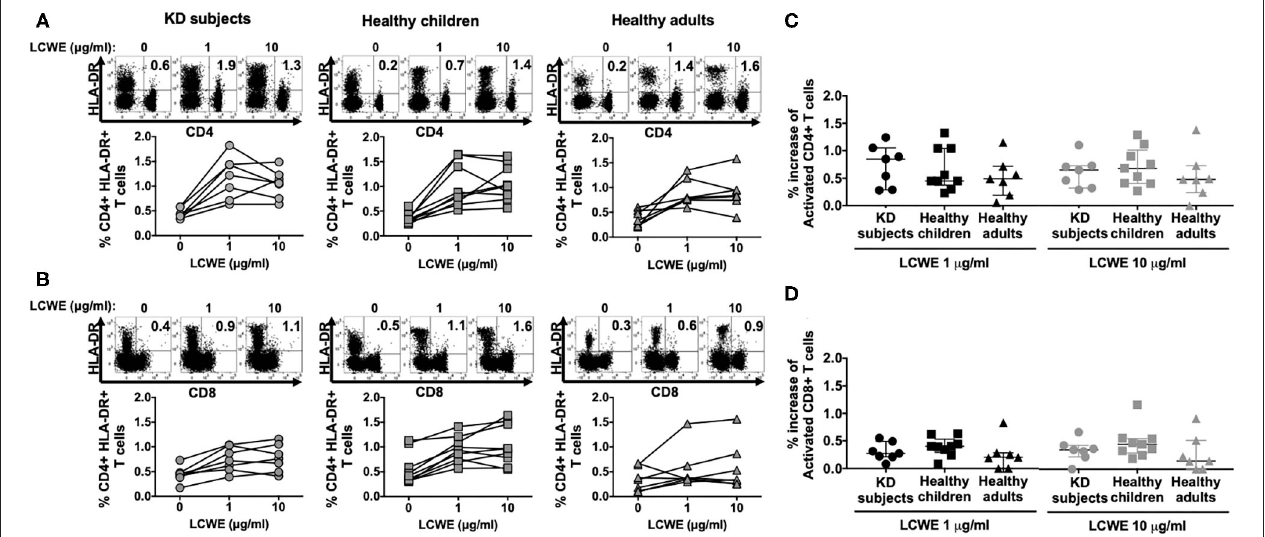
FIGURE 1 | Activation of circulating CD4 + and CD8 + T cells in response to LCWE. PBMC from KD subjects ( n = 7) 2 to 4 weeks after disease onset, healthy children ( n = 9), and healthy adults ( n = 7) were stimulated with 1 and 10 µ g/ml of LCWE for 4 days and the percent activated CD4 + HLA-DR + (A) and activated CD8 + HLA-DR + (B) T cells were enumerated by flow cytometry with specific monoclonal antibodies. Unstimulated PBMC cultures served as controls in these experiments. A representative FACS plot of HLA-DR expression on CD4 + and CD8 + T cells for each cohort is shown. Percent increase of CD4 + HLA-DR + (C) and CD8 + HLA-DR + (D) T cells in response to 1 µ g/ml (dark symbols) and 10 µ g/ml (light symbols) of LCWE vs. un-stimulated control. The data are shown with median and interquartile range. Each symbol is the result derived from each subject tested. The statistical differences between cohorts were tested by one-way ANOVA. A P < 0.05 was considered significant. The results suggested that LCWE stimulates CD4 + (1 µ g/ml, p = 0.5564; 10 µ g/ml, p = 0.6553) and CD8 + (1 µ g/ml, p = 0.3947; 10 µ g/ml, p = 0.3405) T cells in the 3 cohorts with no statistical